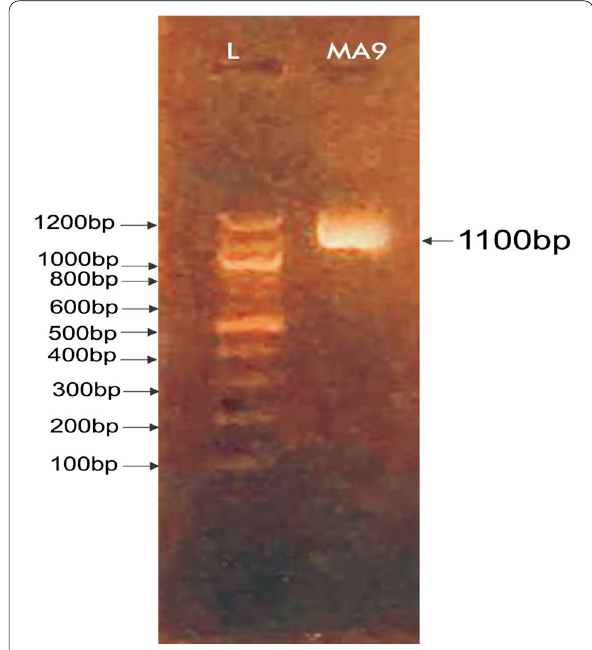
Fig. 1 Gel image of Lactobacillus fermentum (MA 9) at 1100